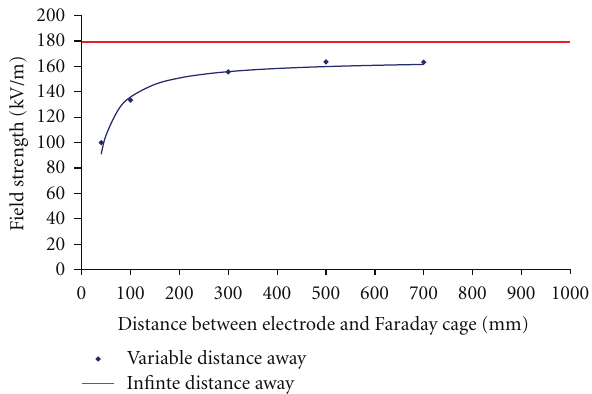
Figure 2: Graph to show the a ff ect on the field strength (0.2 mm above the bottom electrode) by altering the distance between faraday cage and apparatus.